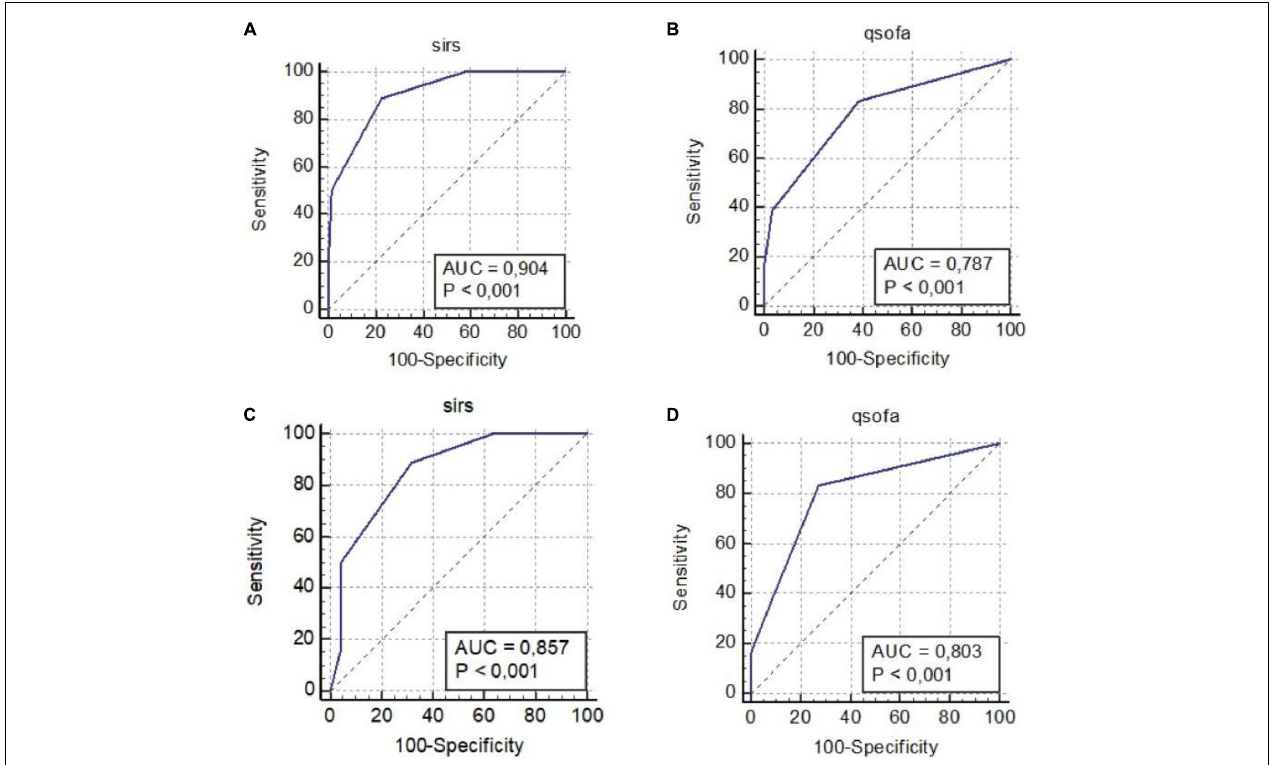
FIGURE 2 | ROC curves: SIRS criteria Group 1 vs. Group 2 (A) , q-SOFA criteria Group 1 vs. Group 2 (B) , SIRS Criteria Group 1 vs. Group 3 (C) , and q-SOFA criteria Group 1 vs. Group 3 (D) . AUC, area under the curve; q-SOFA, quick Sequential Organ Failure Assessment; SIRS, systemic inflammatory response syndrome; SOFA, sequential organ failure assessment.